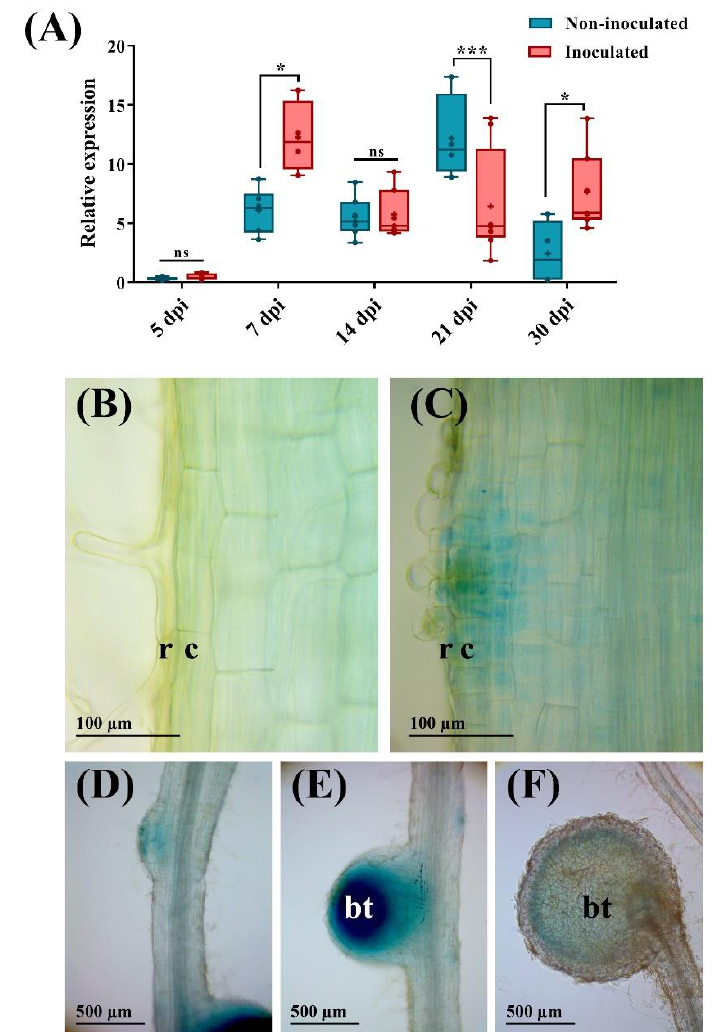
Figure 2. Expression profile analysis of PvMT1A . ( A ) Relative PvMT1A expression in P. vulgaris roots at 5, 7, 14, 21, and 30 dpi with R. tropici CIAT899 evaluated by qPCR . The elongation factor EF1α and IDE genes were used as endogenous reference genes to normalize expression levels. The blue bars represent non-inoculated roots, and the red bars represent roots inoculated with R. tropici at the indicated times. The top and bottom edges of the boxes delineate the first to third quartiles, the horizontal line within the box represents the median, and the whiskers indicate the smallest and largest outlier in the data set ( n = 9). A non-parametric Mann–Whitney test was performed to evaluate significant differences, * p ≤ 0.05 , *** p ≤ 0.001, and ns = no significant difference. ( B – F ) Promoter activity of PvMT1A visualized by GUS staining in non-inoculated ( B ) or inoculated ( C – F ) roots carrying p PvMT1A ::GFP:GUS. ( B ) non-infected root hair, ( C ) curled root hair after rhizobial infection at 7 dpi, ( D ) nodule primordium at 30 dpi, ( E ) young nodule at 30 dpi, ( F ) mature nodule at 30 dpi. r, rhizodermis; c, cortex; bt, bacteroid tissue.